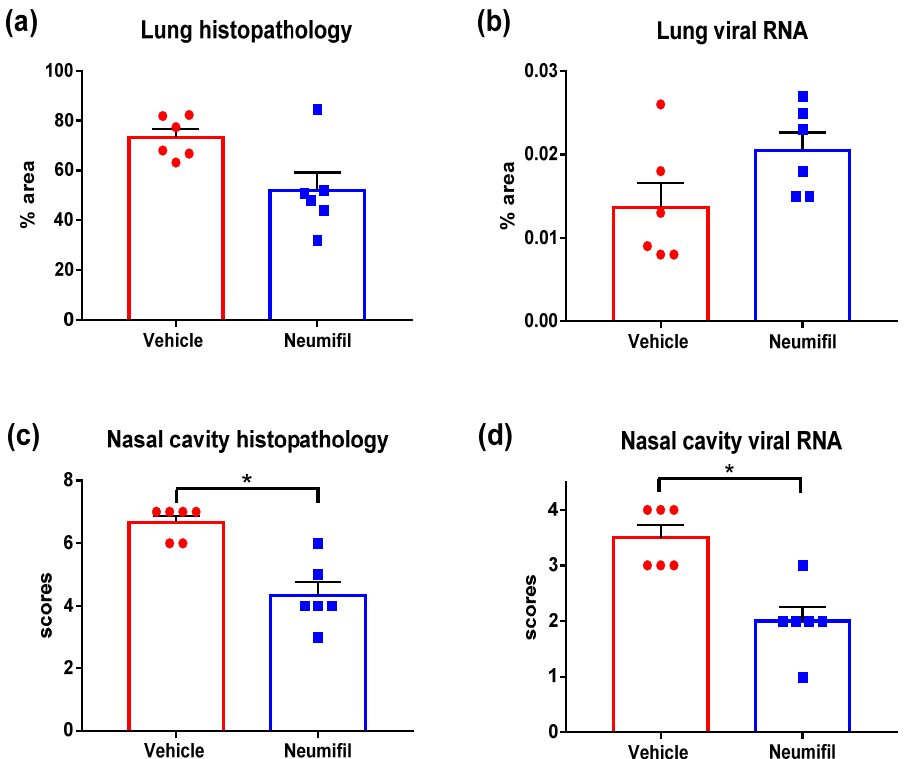
Figure 4. Quantitative analysis of histological specimens from Neumifil-treated and vehicle-treated animals after SARS-CoV-2 challenge: ( a ) percentage of area of pneumonia in the lung; ( b ) percentage of area positively stained for viral RNA in the lung using in situ hybridisation; ( c ) cumulative scores of nasal cavity lesions (presence of exudates and necrosis of epithelium); ( d ) subjective scores of viral RNA presence in the nasal cavity using in situ hybridisation. Bars show mean values with error bars denoting standard error of the mean. * p < 0.05 (Mann–Whitney test). n = 6 hamsters per group.